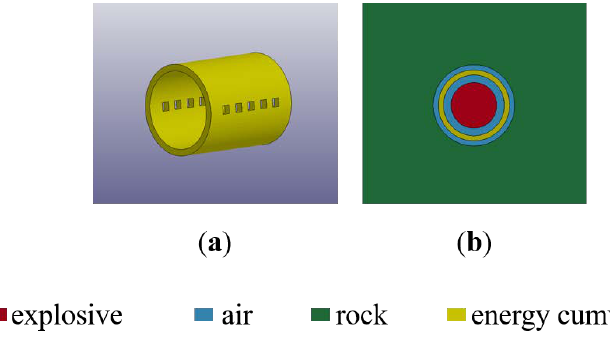
Figure 9. Schematic diagrams of numerical model. ( a ) energy cumulative tube; ( b ) cumulative